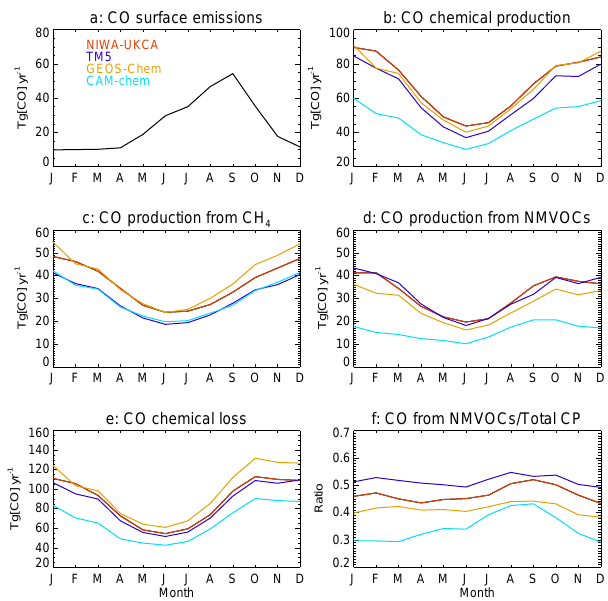
Figure 16. Monthly CO surface emissions, chemical production and loss terms, and the ratio of NMVOC oxidation to total chemical production in the SH. Data are for